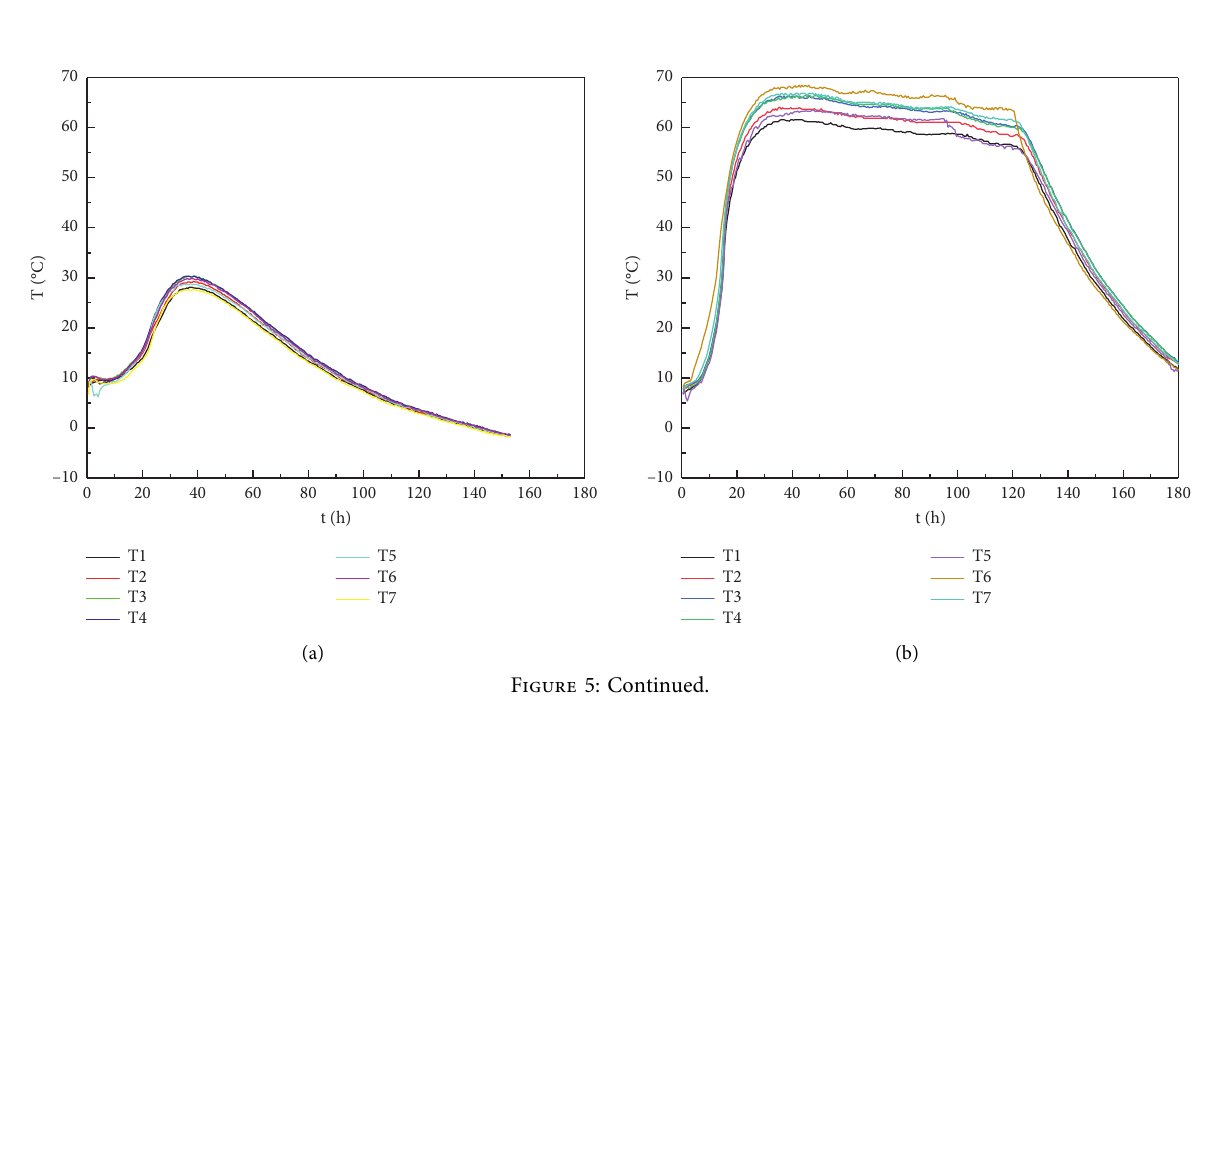
Figure 4: Schematic diagram of drill core sampling locations (cm): (a) front view and (b) top